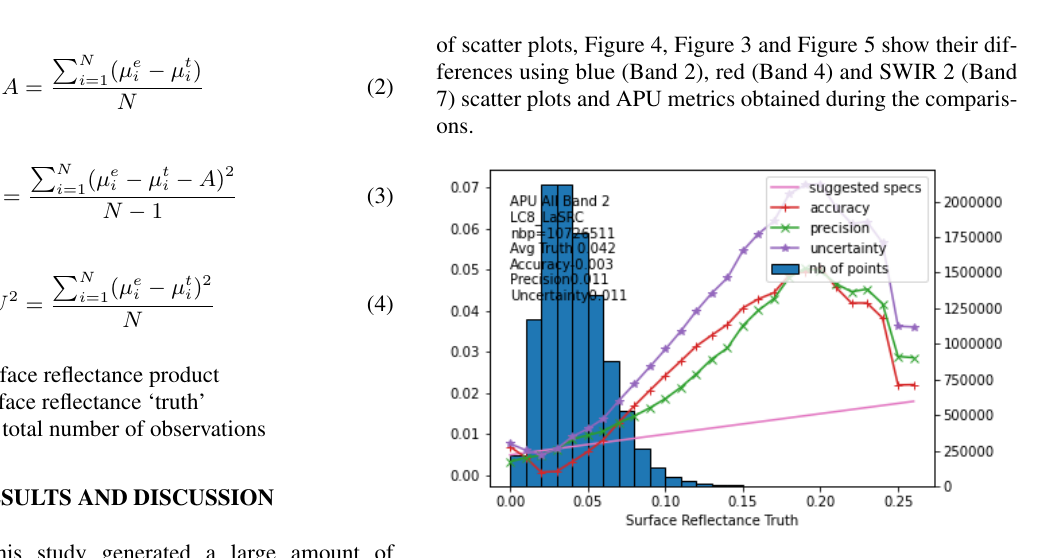
Figure 2. Methodology diagram containing surface reflectance images generation and validation.